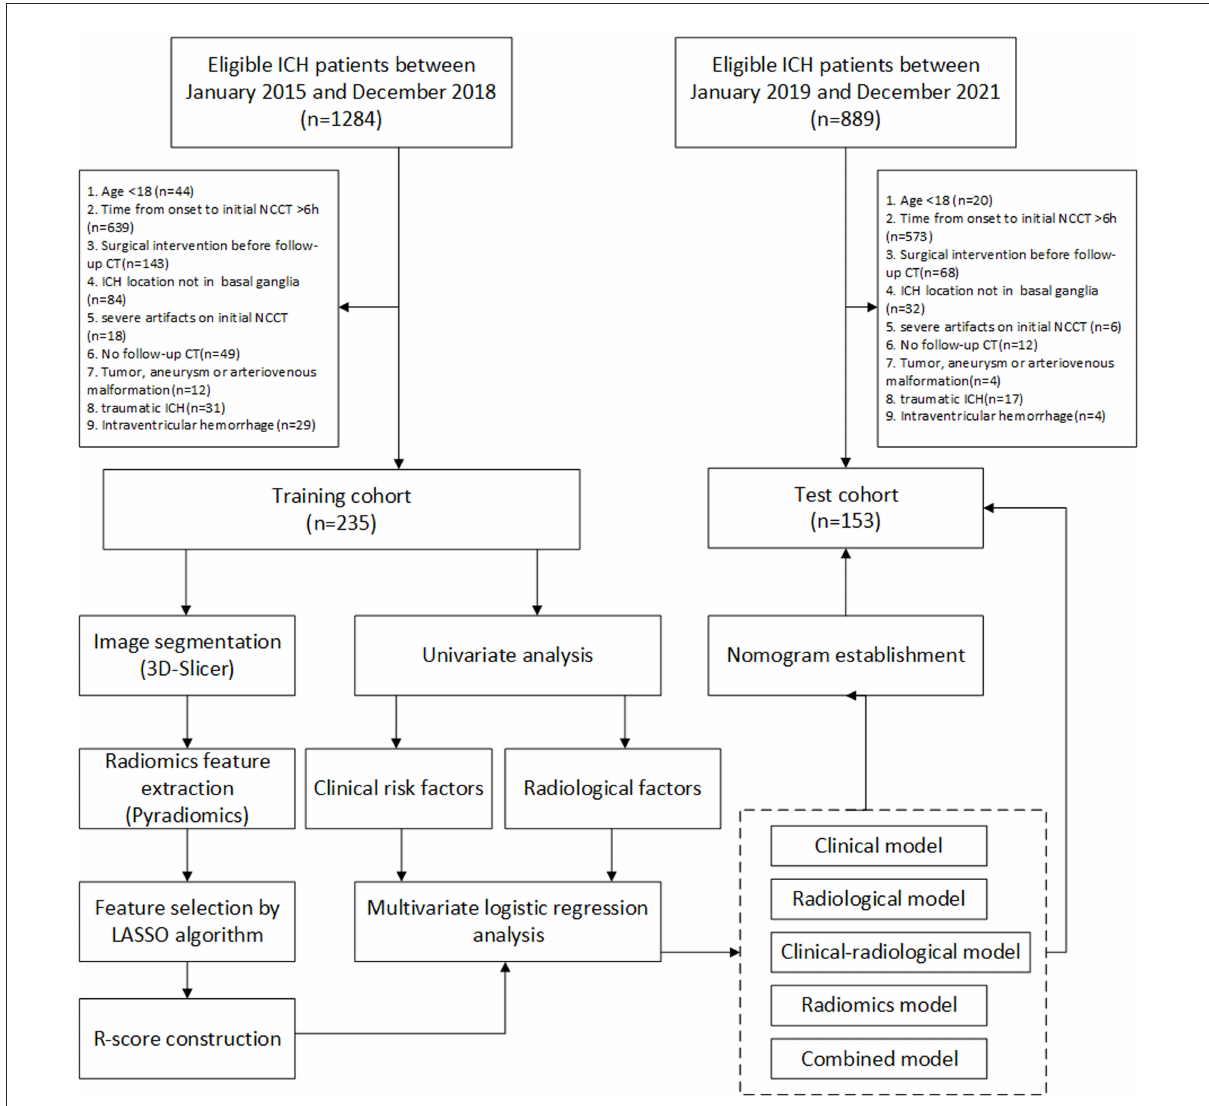
FIGURE1 The workflow of this study. LASSO, least absolute shrinkage and selection operator; NCCT, non-contrast computed tomography. ICH, intracerebral hemorrhage.